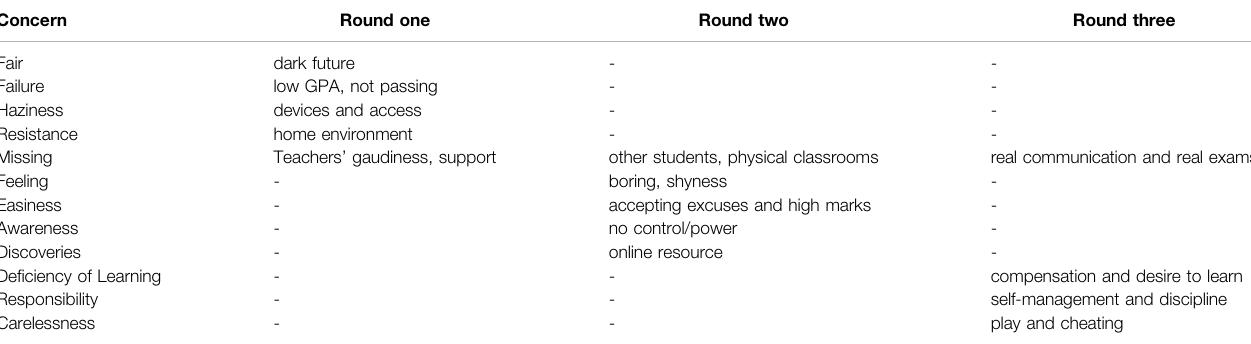
TABLE 4 | The emergent concerns and indicative examples from each re fl ective round.